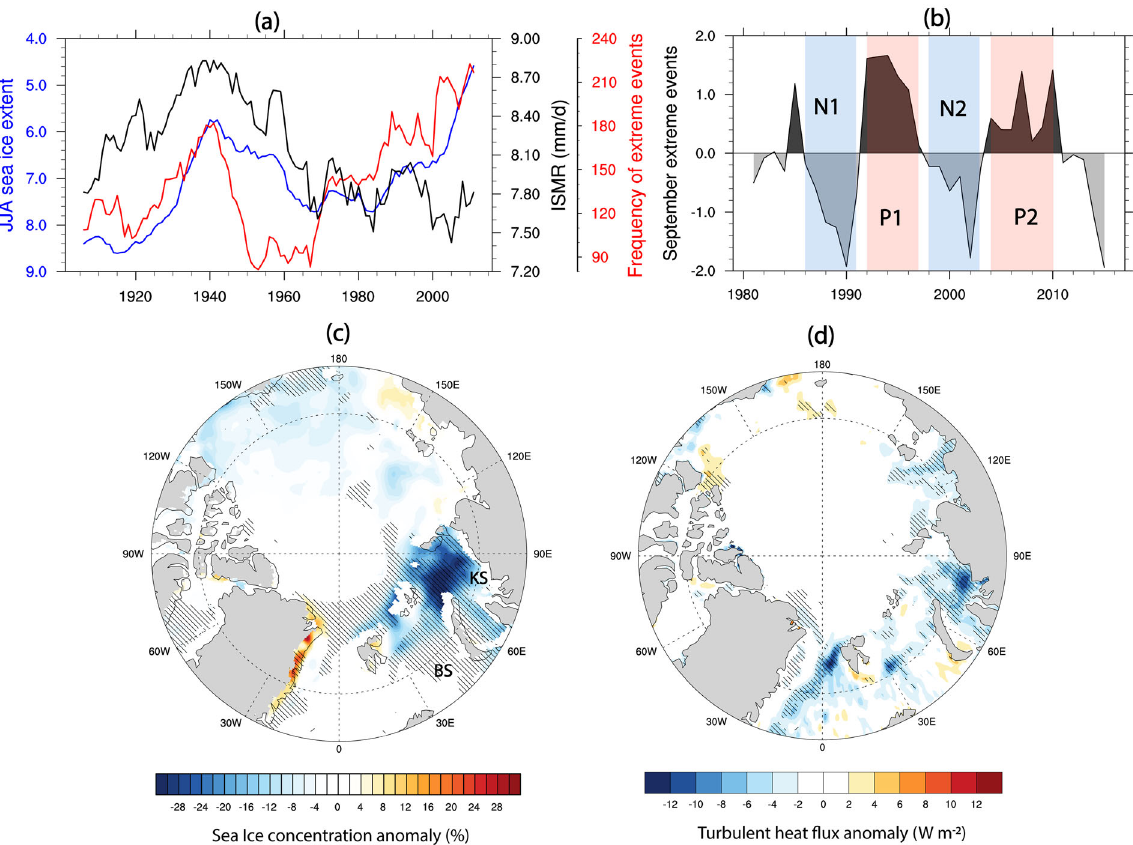
Fig. 1 Observed relation between SIE, SIC in the Kara Sea (KS), and ISMR. a SIE (10 5 sq. km) during JJA in the KS region of the Arctic Ocean (blue line, note that the scale is reversed), number of grid cells in central India (19 o N – 26 o N; 75 o E – 85 o E) with rainfall exceeding 150 mm day − 1 during JJAS (red line), averaged rainfall over central India during JJAS (black line). All time series are smoothed with 11-yr running mean. b Anomalies in number of grid points in central India (19 o N – 26 o N; 75 o E – 85 o E) with rainfall exceeding 150 mm day − 1 during September. The time series is generated by removing the time mean (for 1980 – 2017) of number of grid points satisfying the above criteria from the respective individual year values, smoothing with a 5-yr running mean, and fi nally detrended and normalized. Episodes of increased (red shaded)/ reduced (blue shaded) September extreme rainfall years are identi fi ed when the time series is positive/negative for at least fi ve consecutive years. c Averaged difference in anomalous JJA sea ice concentration (%) between years with the increased (P1: 1992 – 1997 and P2: 2004 – 2010) and reduced (N1: 1986 – 1991 and N2: 1998 – 2003) extreme rainfall years in September. d Same as in ( c ) but for turbulent heat fl ux (latent + sensible, W m − 2 ). Signi fi cant differences at 90% are dashed in ( c ) and ( d ). Barents Sea (BS) and Kara Sea (KS) regions are marked in ( c